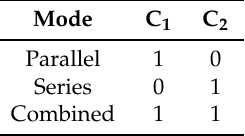
Table 1. Vehicle